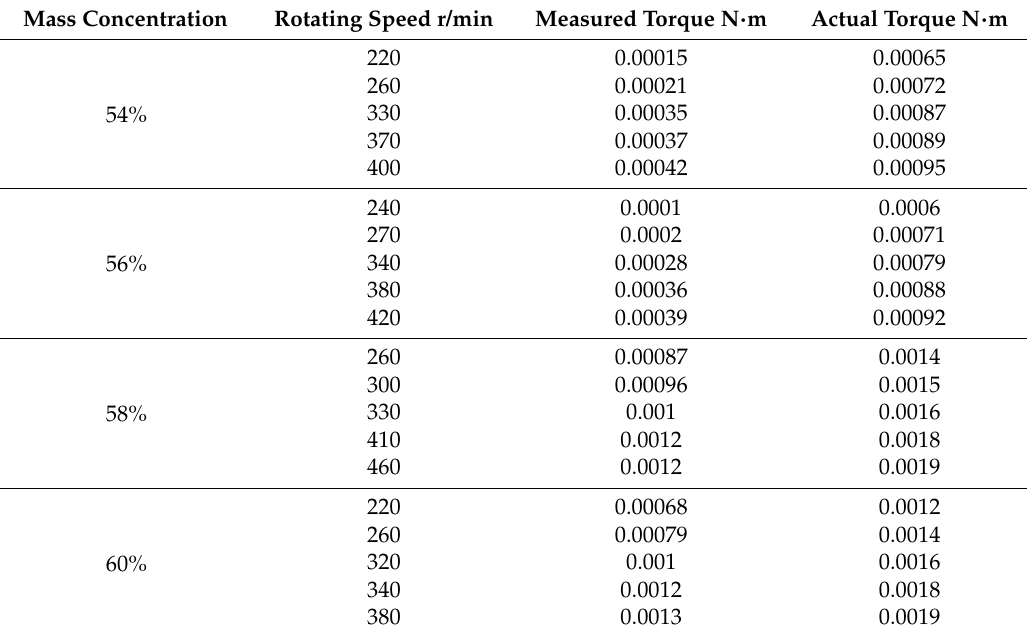
Table 5. Test values under different